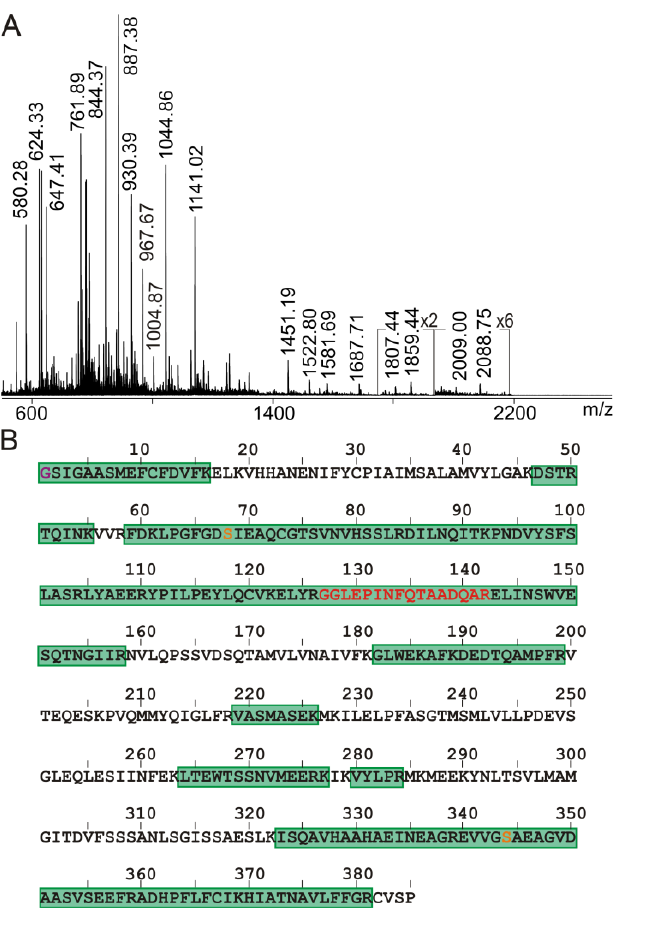
Figure 3. Characterization of the Ovalbumin antigen. ( A ) NanoESI mass spectrum of ions from Ovalbumin upon tryptic digestion (solution 2′). Selected ion signals are labeled. Ion intensity multiplication factors are provided. Peptide concentration is 0.28 µg/µL. 2.5 µL were loaded. Solvent: 200 mM ammonium acetate, pH 6.7. Recording time is 1 min. ( B ) Amino acid sequence of chicken Ovalbumin (P01012; single letter code). Sequence parts that match with peptide ion signals are shaded in green (sequence coverage: 60%). Modified amino acid residues are highlighted in orange (cf. Table S2). The epitope peptide sequence is printed with red